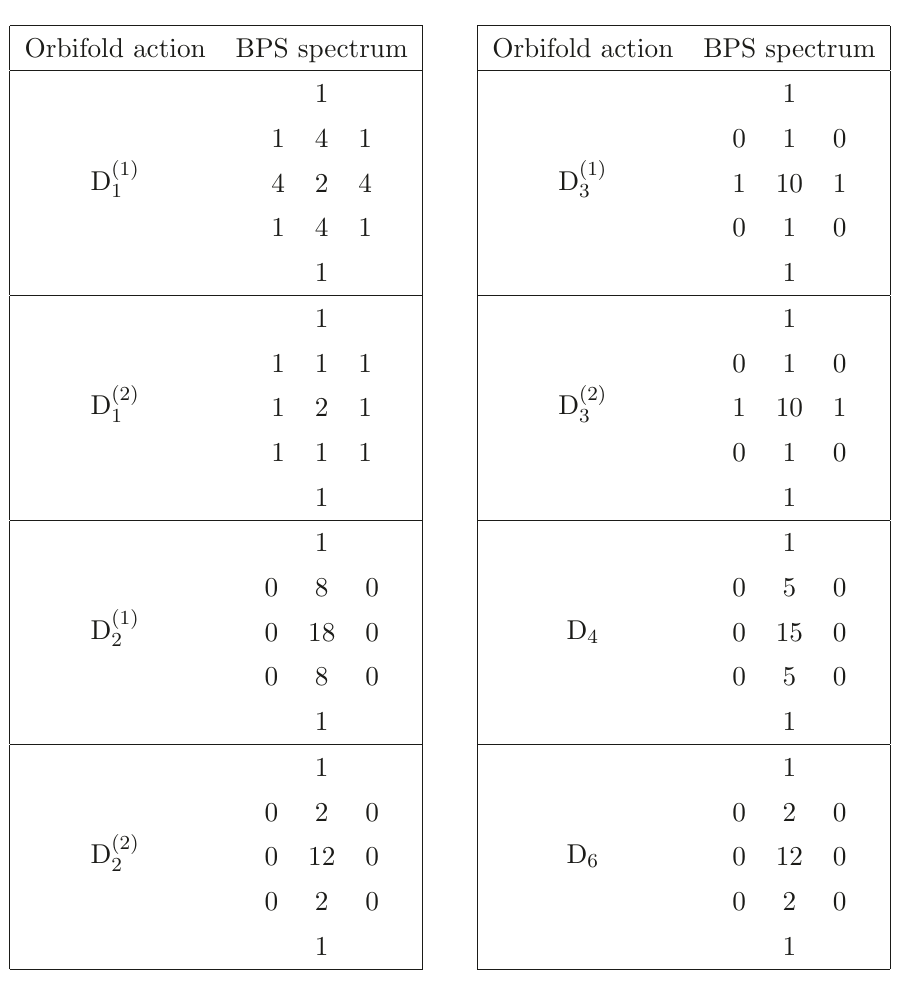
Table 1 . BPS spectra of the torus orbifolds. The different entries are the non-vanishing Hodge , 1 , 3 , 2 } with p + q ∈ N 0 . Recall that D i specifies the orbifold numbers h p,q , where p, q ∈ { 0 , 1 2 2